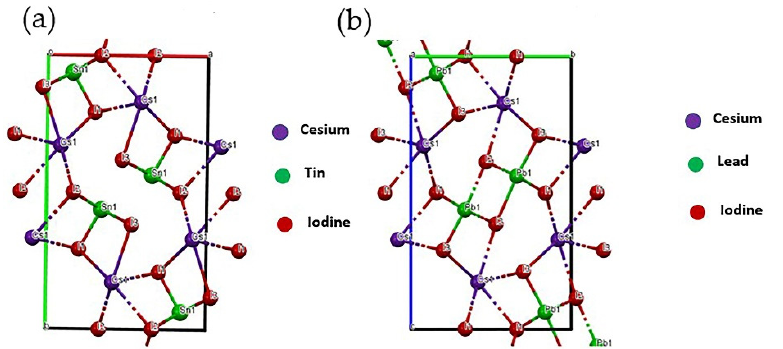
Figure 2. ( a ) Crystal structure of CsSnI 3 (ICSD 14070) with Pnam space group, lattice parameters: a(Å) = 10.346, b(Å) = 17.656, c(Å) = 4.741 with Cesium, Tin, and Iodine; ( b ) crystal structure of orthorhombic δ -CsPbI 3 (ICSD 27979) with Pmnb space group, lattice parameters: a(Å) = 4.788, b(Å) = 10.432, c(Å) = 17.758 with Cesium, Lead, and Iodine. Both the figures are reproduced in Mercury software.